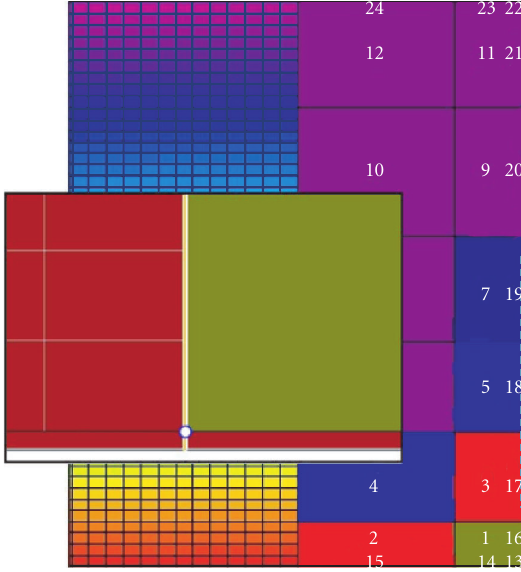
Figure 4: Zone discretization of rectangular cross-section with blowup of zone